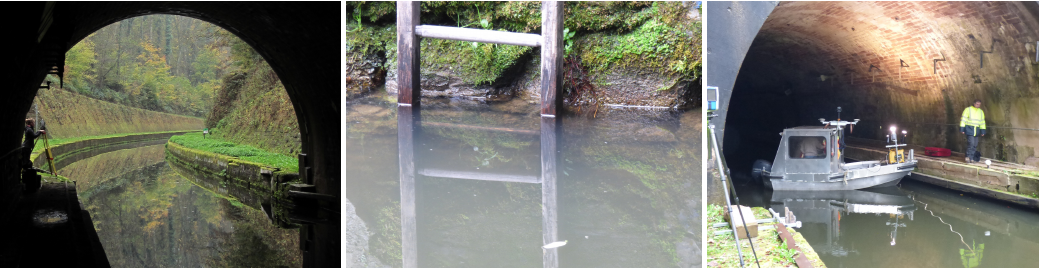
Figure 2. Constraints that apply to recording systems in tunnel canals. ( Left ) Global navigation data are not available in tunnels, nor at their entrances, because satellites are masked, hindering conventional mobile mapping; ( Center ) The turbidity of water prevents using optical imaging devices; ( Right ) The canal is shallow and narrow, so robust sonar processing algorithms are